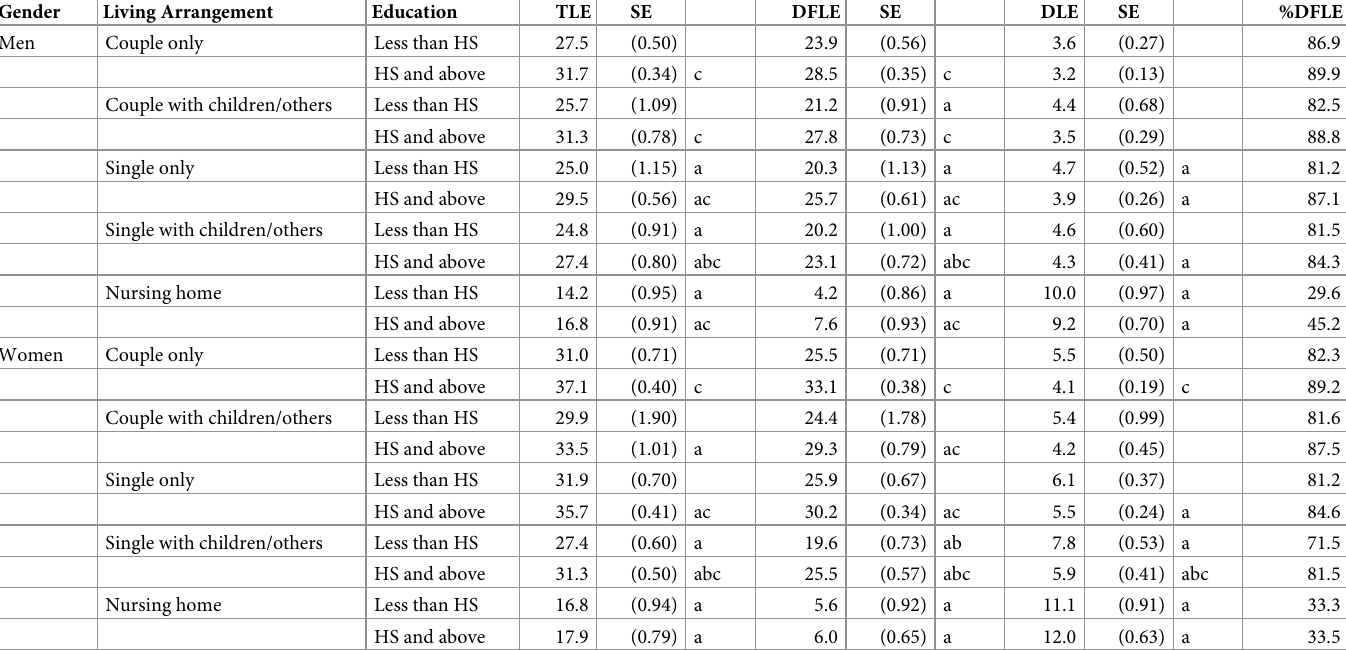
Table 11. Total, disability-free, and disabled life expectancy by gender, living arrangement, and education for non-Hispanic whites at age 50: Status-based estimates with initial health state being